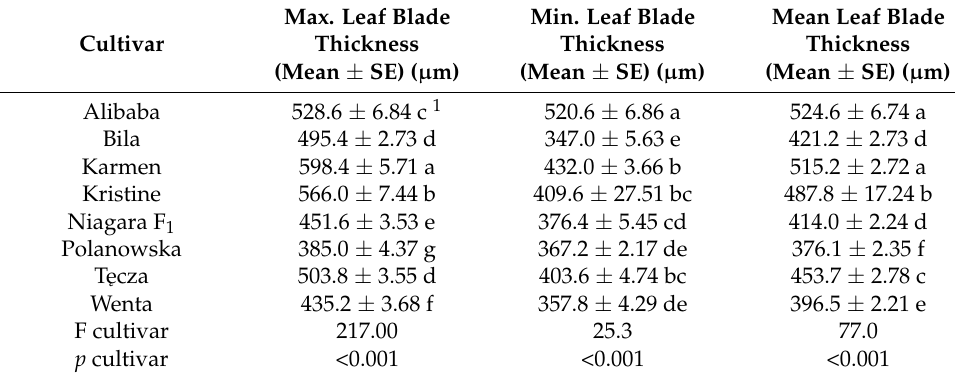
Table 7. Leaf blade thickness of the tested Alium cepa cultivars in 2016, df = 7.